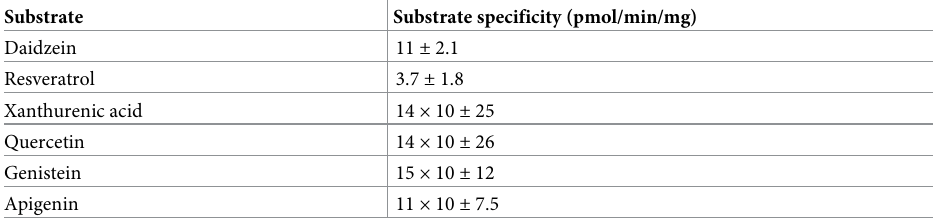
Table 2. Substrate specificities of sw SULT ST3.